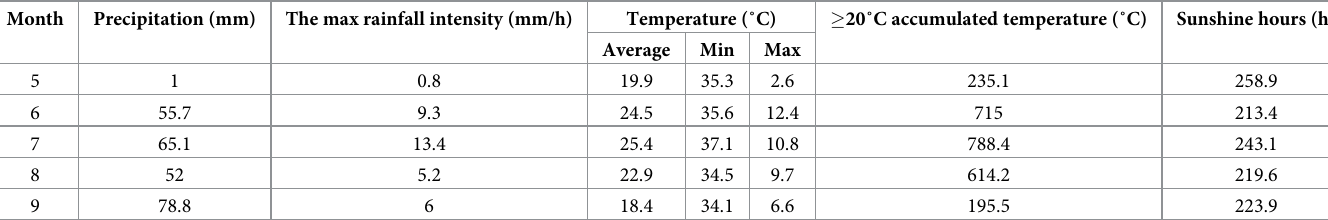
Table 1. Meteorological data of the experimental sites during May-September in 2019.